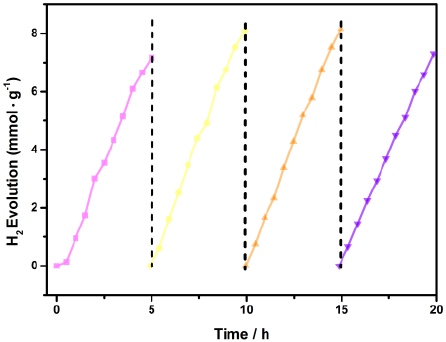
Figure 12. Photocatalytic stability performance of Pt/0.5% Co 3 O 4 /g-C 3 N 4 .